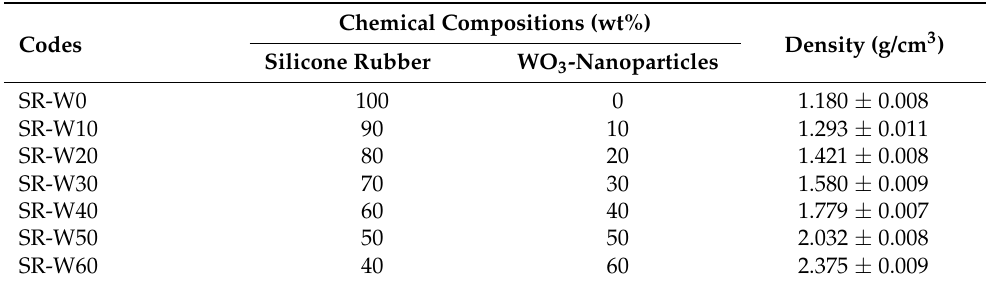
Table 1. Chemical composition, densities, and the codes of the prepared flexible samples.